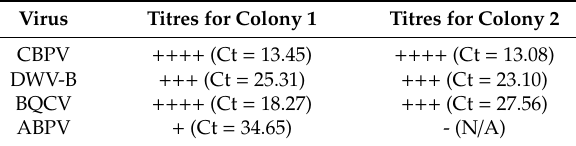
Table 1. Virus titres detected in two honey bee colonies in May 2019. Virus Titres for Colony 1